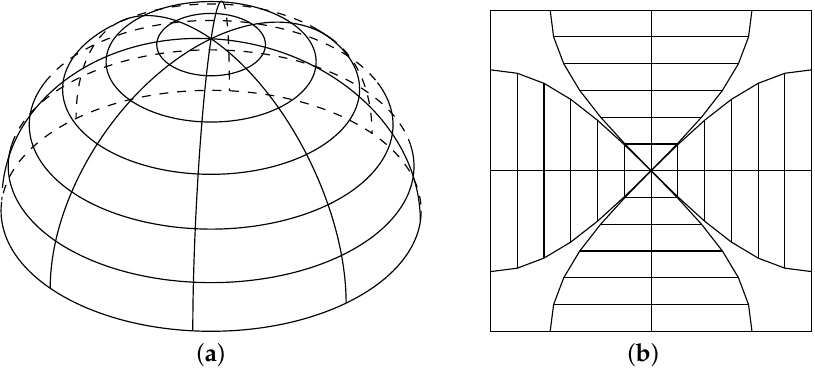
Figure 5. Flatten the hemisphere ( a ) into a plane ( b